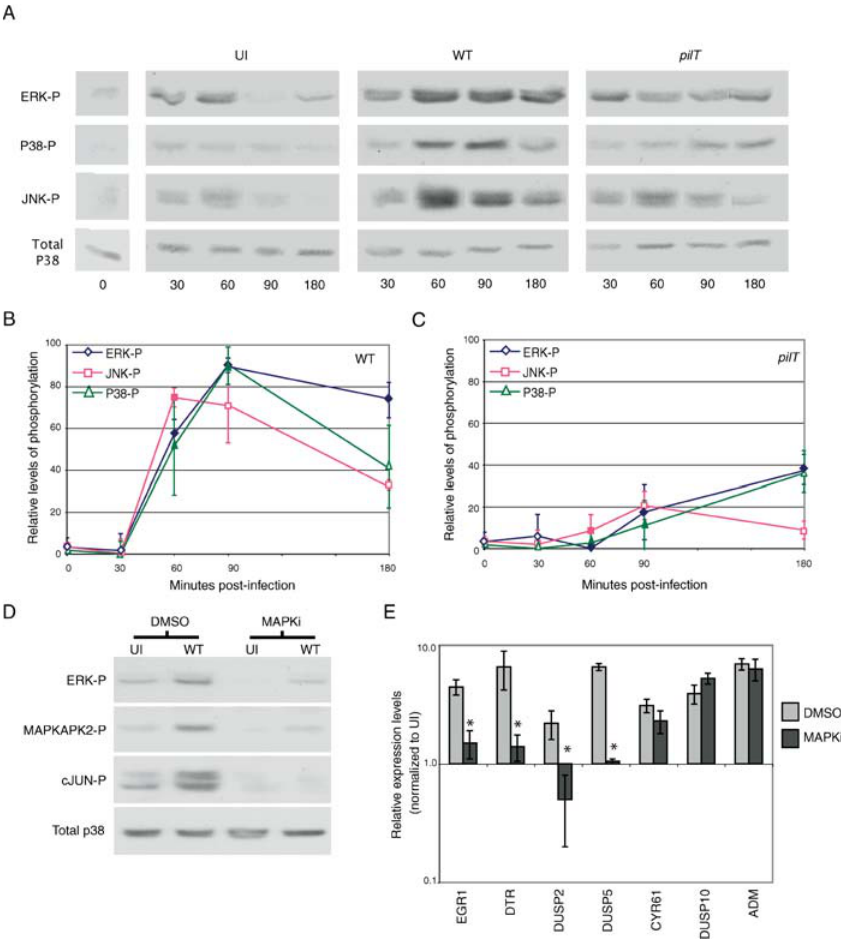
Figure 3. Levels of Activated MAPK in Infected Cells and Their Involvement in Retraction-Enhanced Gene Expression (A) Representative immunoblot showing ERK-p, P38-p, and JNK-p, in uninfected cells before (0 h) and after medium change (UI), or in cells infected with N400 (WT) or N400 pilT (pilT). Total P38 protein levels in each sample served as the internal control (bottom lanes). (B and C) ERK-p JNK-p, and P38-p levels over time in cells infected with N400 and N400 pilT, respectively. Immunoblots from (A) were analyzed by densitometry, and levels of activated kinase from infected cells were normalized to that from uninfected cells (UI). Values represent mean normalized protein levels ( 6 SEM, n = 2). Solid markers indicate a significant difference between wt and pilT -induced MAPK phosphorylation at that time point ( p , 0.05); thus, ERK-p is significant at 60, 90, and 180 min; JNK-p is significant at 60 min; and P38-p is significant at 60 and 90 min. (D) Representative immunoblot showing ERK-p, MAPKAPK2-p, and c-Jun-p in cells preincubated with vehicle (DMSO) or MAPK inhibitors and infected for 90 min with N400 (WT) or left untreated (UI). Total P38 protein levels in each sample served as the internal control (bottom lanes). (E) Real-time quantitative RT-PCR analysis of the effect of MAPK inhibitors on the expression of retraction-responsive genes. Light bars indicate cells infected with N400 in the presence of vehicle (DMSO); dark bars indicate cells infected with N400 in the presence of MAPK inhibitors. Values represent the fold-change ( 6 SEM, n = 2) in transcript levels compared to uninfected, DMSO treated control. A significant difference in expression between the two conditions is denoted by an asterisk ( p , 0.1). DOI: